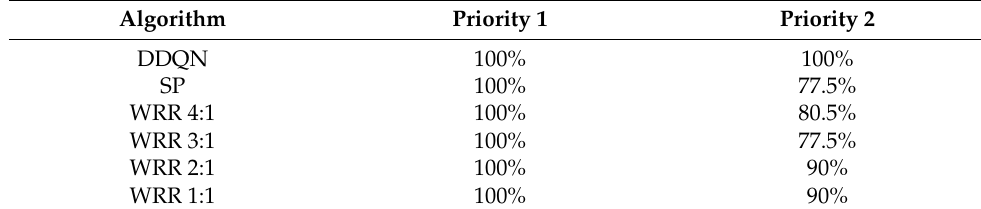
Figure 8. Boxplot comparing the scores of schedulers. The DDQN, after learning, achieved perfor- mance of a normalized score close to 100% even though parameters were changed, proving that it would adapt well to dynamic environments.